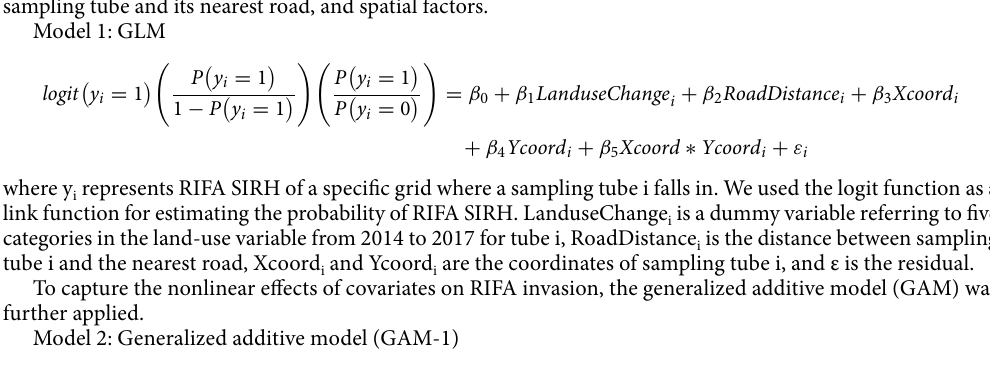
Model 2: Generalized additive model (GAM-1)